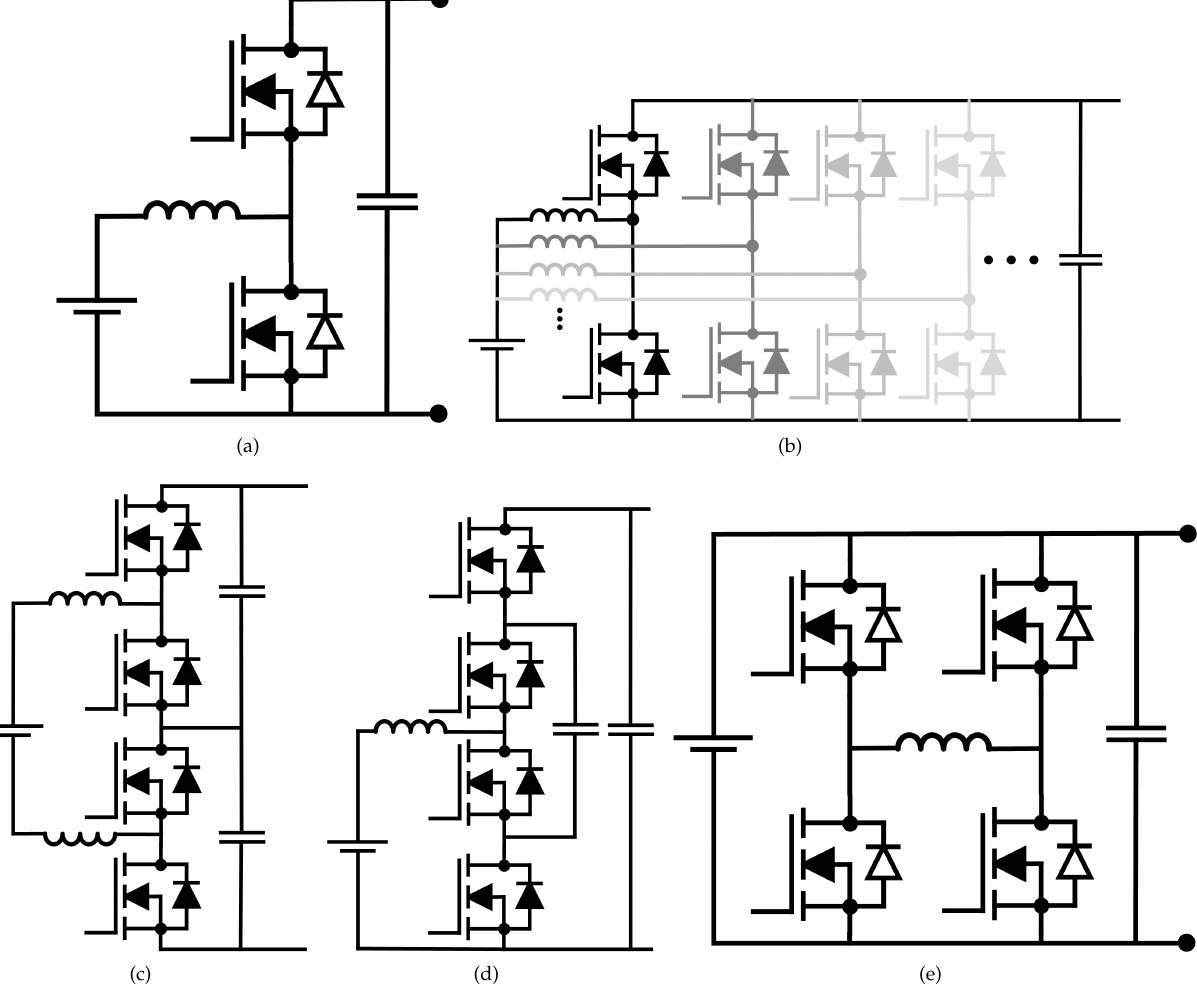
Figure 6. Non-isolated DC/DC converters: ( a ) Conventional buck converter; ( b ) Interleaved buck converter; ( c ) 3-level NPC buck converter; ( d ) 3-level FC buck converter; ( e ) Non-inverting buck-boost